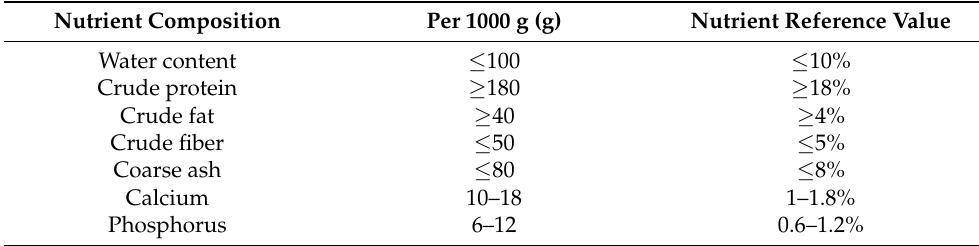
Table 2. Composition of the normal maintenance feed